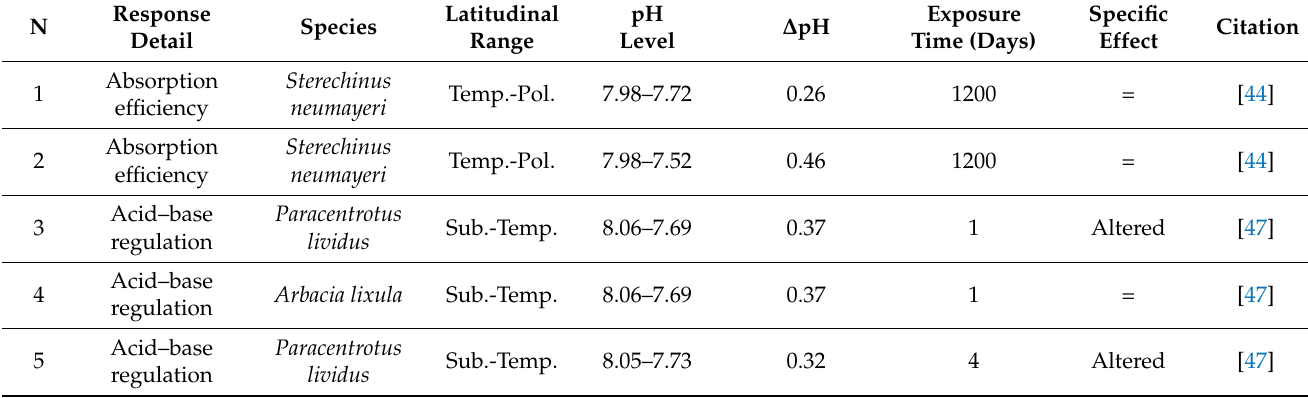
Table 2. List of studies performed on echinoid adult stage to investigate effects of SWA on physiology. “pH level” contains the value of all the conditions tested; the first value is the control. In the case that the same article tested both a realistic ( ∆ pH ≤ 0.4; based on IPCC RCP8.5) and unrealistic scenario ( ∆ pH > 0.4), the two conditions were split. Abbreviations: Eq.-Trop. = Equatorial–Tropical; Sub.-Temp. = Subtropical–Temperate; Temp.-Pol. =